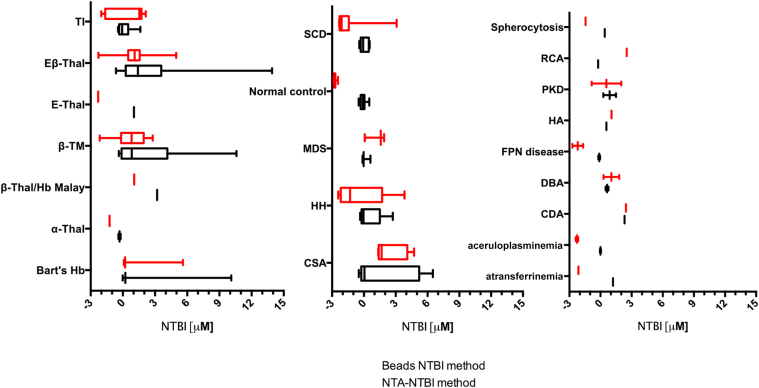
Box and whisker plot (range) of NTBI in healthy controls and various conditions of iron overload using a standard analytical method (NTA-NTBI) and the proposed bead-based NTBI method. NTA, nitrilotriacetate; NTBI, nontransferrin-bound iron.